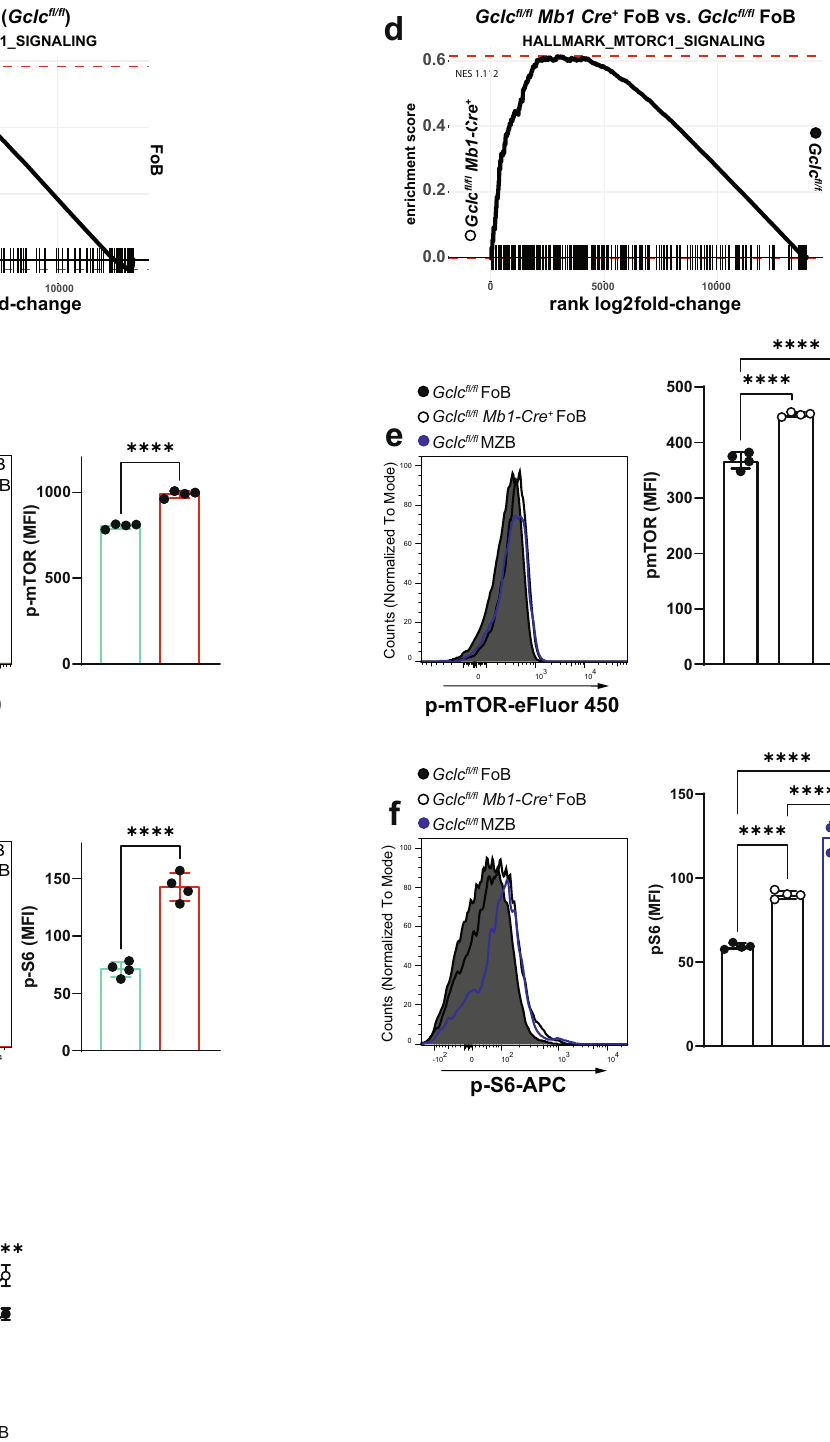
characterization and interpretation of metabolic diversity at